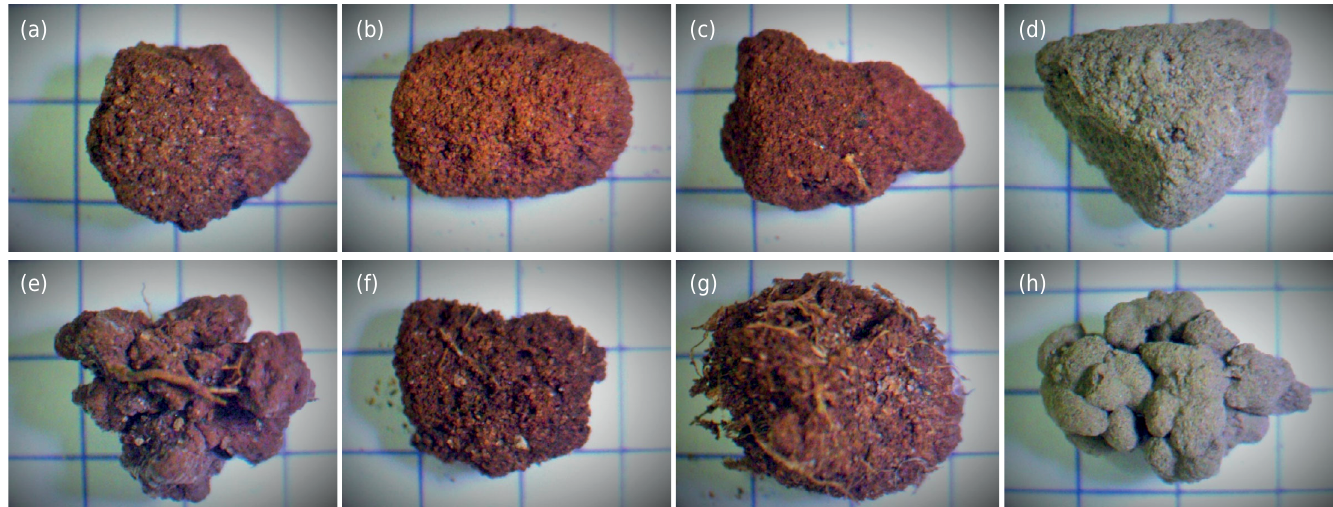
Figure 1. Examples of the morphological differentiation of biogenic (Bio) and physicogenic (Phy) aggregates in areas under different management systems and native forest in southern Brazil. (a) Phy from permanent pasture; (b) Phy from no-tillage system; (c) Phy from no-tillage + Brachiaria system; (d) Phy from Atlantic Forest biome vegetation; (e) Bio from permanent pasture; (f) Bio from no- tillage system; (g) Bio from no-tillage + Brachiaria system; and (h) Bio from Atlantic Forest biome